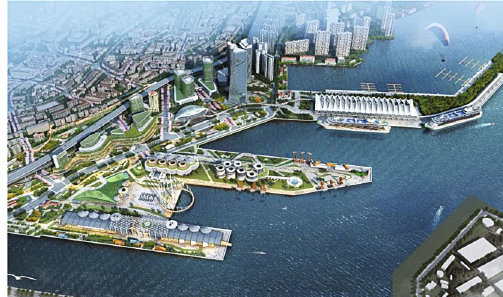
Figure 2: The rendering of Qingdao Cruise Port starting area (source: from the